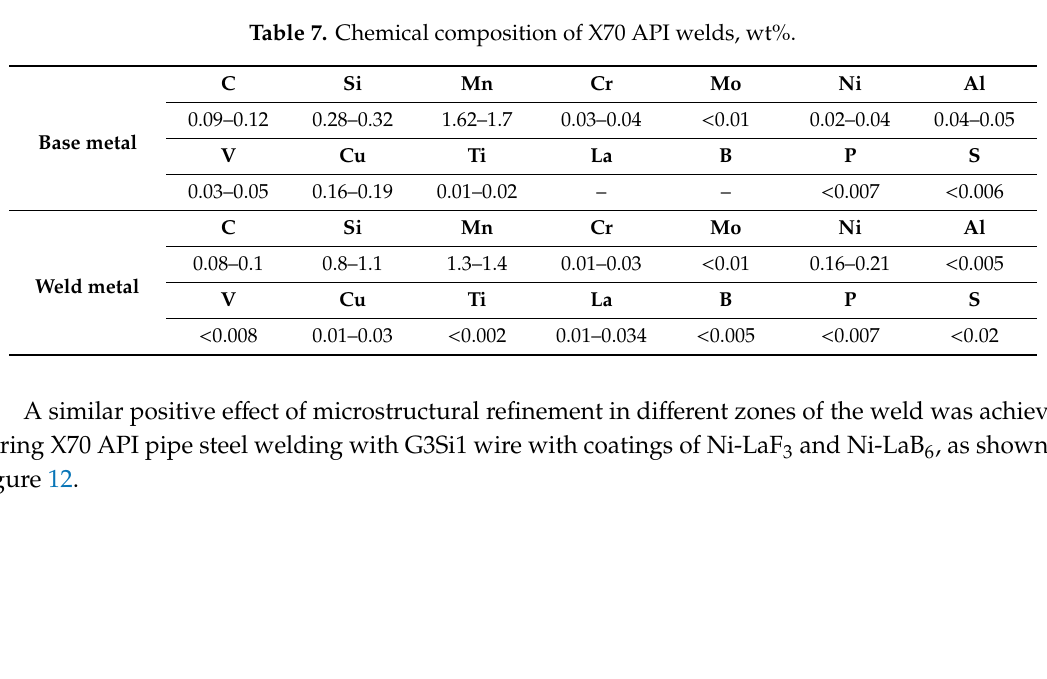
Table 7. Chemical composition of X70 API welds,